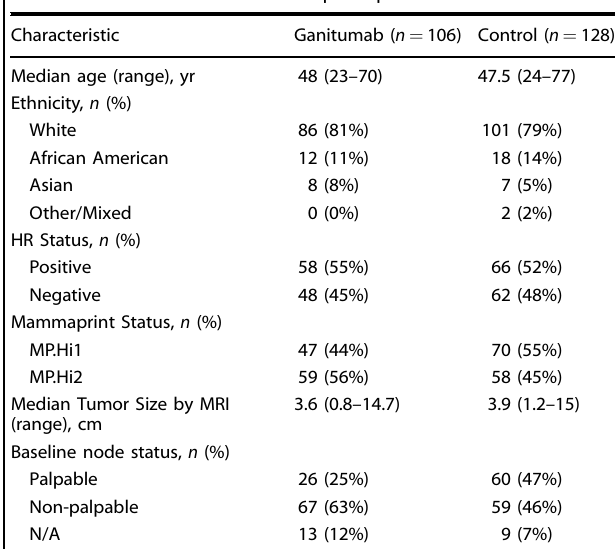
Table 1. Baseline characteristics of participants in each